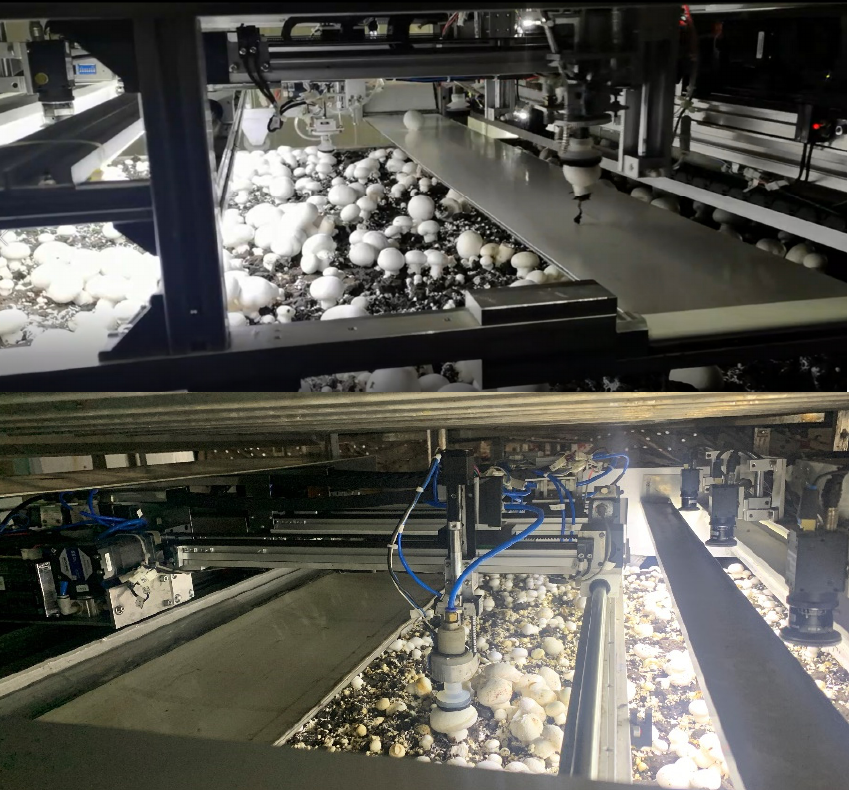
Figure 17. The Agaricus bisporus multi-arm intelligent picking robot working in the multistory shelf trays in the factory environment.